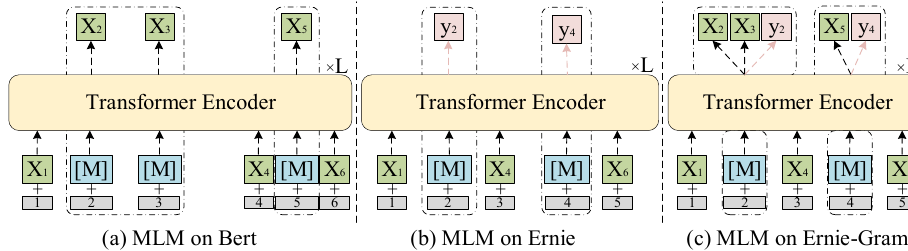
Figure 3. Comparison of MLM task structures with di ff erent strategies.